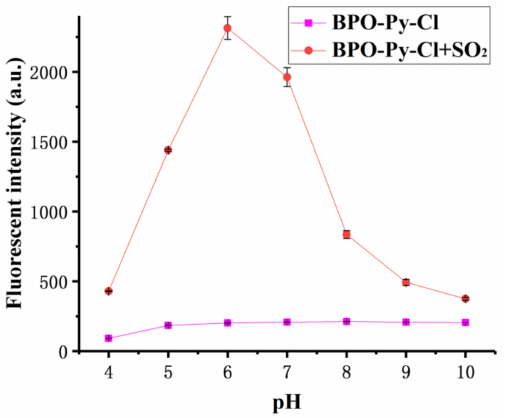
Figure 2. The pH dependent fluorescent changes of BPO-Py-Cl (10 µ M) in PBS or after addition of SO 2 (500 µ M). The experiment was repeated three times ( ±